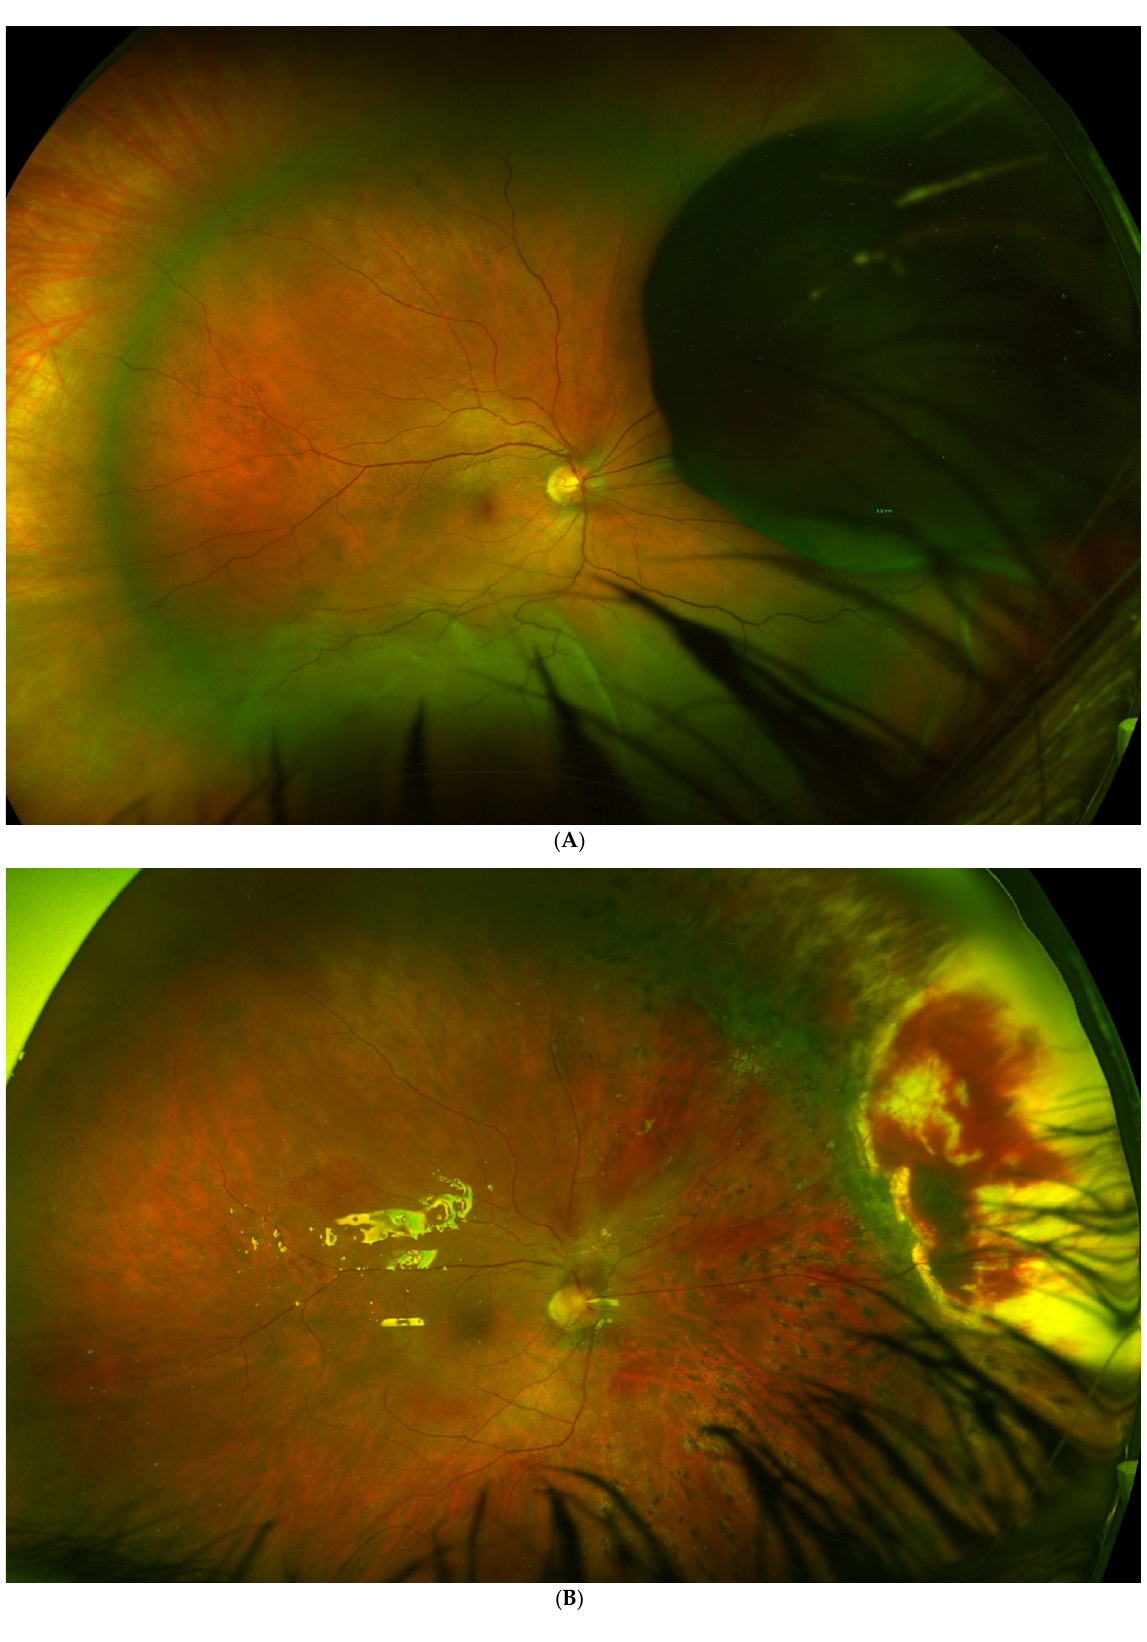
Figure 2. ( A ). Tumour located in the preequatorial and superior nasal quadrant, with extensive inferior retinal detachment, in which a partial lamellar scleral resection was performed. ( B ). Fundus image shows the extensive surgical coloboma, as well as the perilesional photocoagulation and ret- inal reattachment.